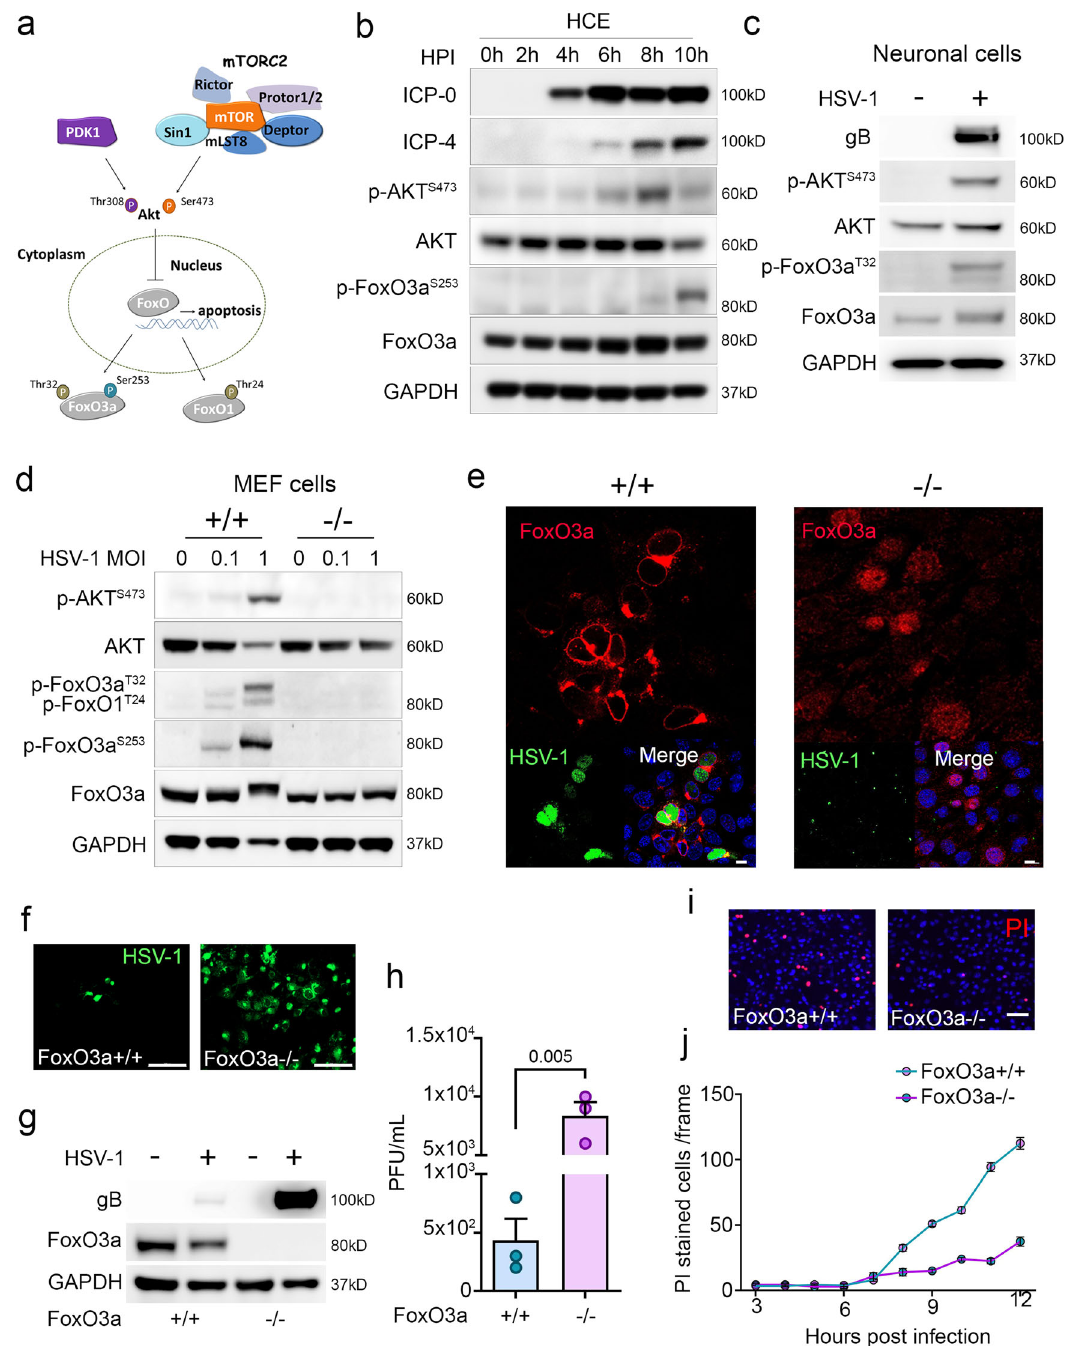
Fig. 4 Rictor/mTORC2 dependent nuclear preclusion of FOXO3a is important for cell survival during virus infection. a Schematic representation of the hypothesis. b Representative western blots showing expression and phosphorylation of respective proteins at different hpi. c Representative western blot illustrating expression and phosphorylation of respective proteins in LUHMES cells. d Representative western blot illustrating expression and phosphorylation of respective proteins in iRic MEF ’ s. e Representative micrograph of immuno fl uorescence confocal imaging illustrating location of FoxO3a, Scale bar 10 µ m. f Representative micrograph of fl uorescence imaging in HSV-1 (GFP tagged) infected cells, Scale bar 200 µ m. g Representative micrograph of western blot showing indicated protein expression. h Plaque assay showing PFU/mL ( n = 3), two-tailed unpaired t -test was used to analyze the data. i A representative micrograph showing PI stained population of HSV-1 infected MEFs at 12 hpi, Scale bar 50 µ m. j A line graph showing PI stained population of HSV-1 infected MEFs. Data are represented as mean ± SEM in h – k . Data in the micrograph ( b – g , i ) is the representative of three independent experiments. Source data underlying b – d, g are provided as a Source Data fi